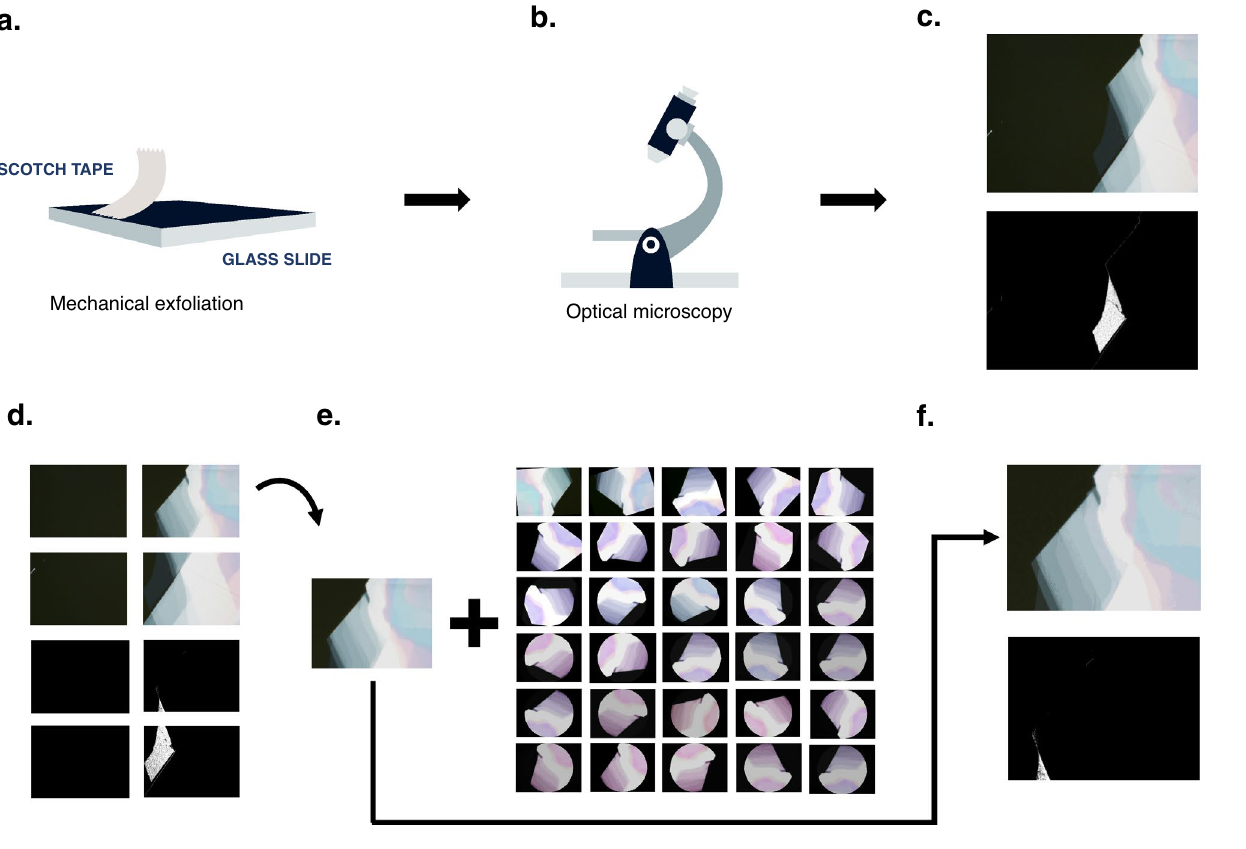
Figure 1. MoSe 2 flake fabrication and image collection and processing. ( a ) Mechanical exfoliation of MoSe 2 with scotch tape to produce flakes which are then ( b ) imaged with optical microscopy. ( c ) A typical optical image of a flake and surrounding bulk material with a masked version of the image below which only displays the flake in white. ( d ) The four resulting images when the original image in ( c ) is divided with the masked version below. ( e ) The resulting 30 images produced through the augmentation methods of padding, rotating, flipping, and color jitter. ( f ) The image recreated with 20 colors again with the masked version